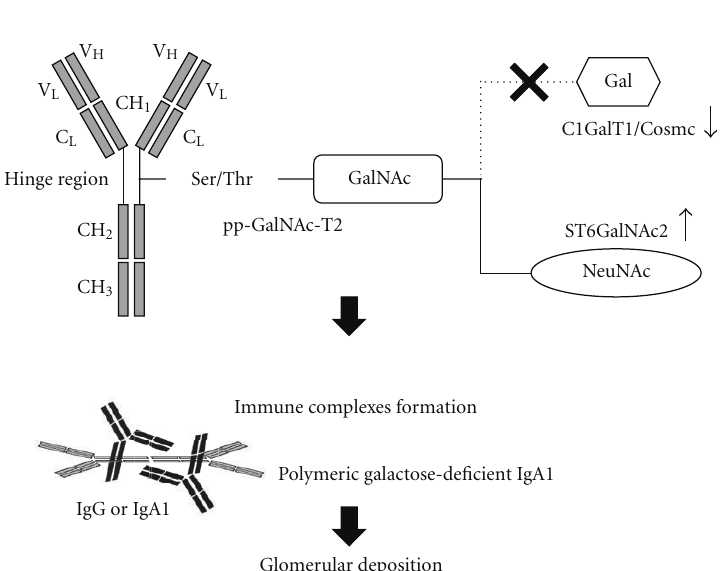
Figure 1: The galactose-deficient IgA1 molecule and the immune complexes formation in the pathogenesis of IgAN. IgA1 has characteristic hinge regions between the CH 1 and CH 2 domains (CH, the constant regions of the heavy chain), which contain at least six serine (Ser) or threonine (Thr) residues as O -linked glycosylation sites. In the first step, the enzyme polypeptide N-acetylgalactosaminyltransferase (pp- GalNAc-T2) facilitates the attachment of N-acetylgalactosamine (GalNAc) to these residues. In the second step, the IgA1 glycosylation is extended in two ways. One is the binding of N-acetylneuraminic acid (NeuNAc) to GalNAc through the action of the enzyme N- acetylgalactosamine-specific α 2,6-sialyltransferas (ST6GalNAc2) [17]. The other is galactose (Gal) connection to GalNAc through the enzyme core 1 β 1,3 galactosyltransferase (C1GalT1) and core-1- β 3-Gal-T specific molecular chaperone (Cosmc) [18]. The imbalance between those activities may promote galactose-deficient IgA1 production [10, 18]. Galactose-deficient IgA1 is aggregated with antiglycan IgG or IgA1 antibodies, resulting in formation of immune complexes [13], which may escape the normal catabolism in liver and also accumulate with high a ffi nity in glomerular